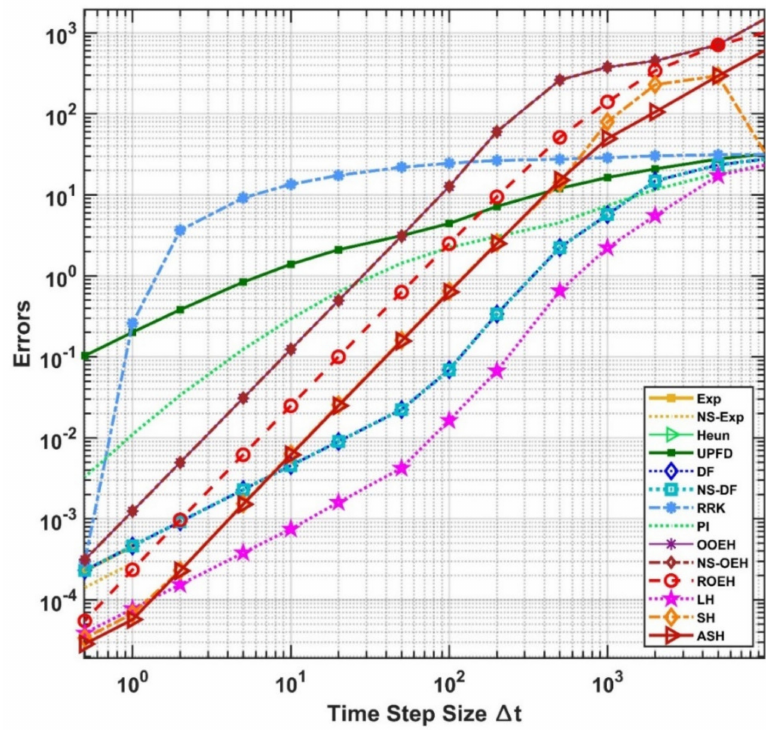
Figure 13. The maximum errors as a function of the time step size ∆ t for the equidistant mesh and thermal